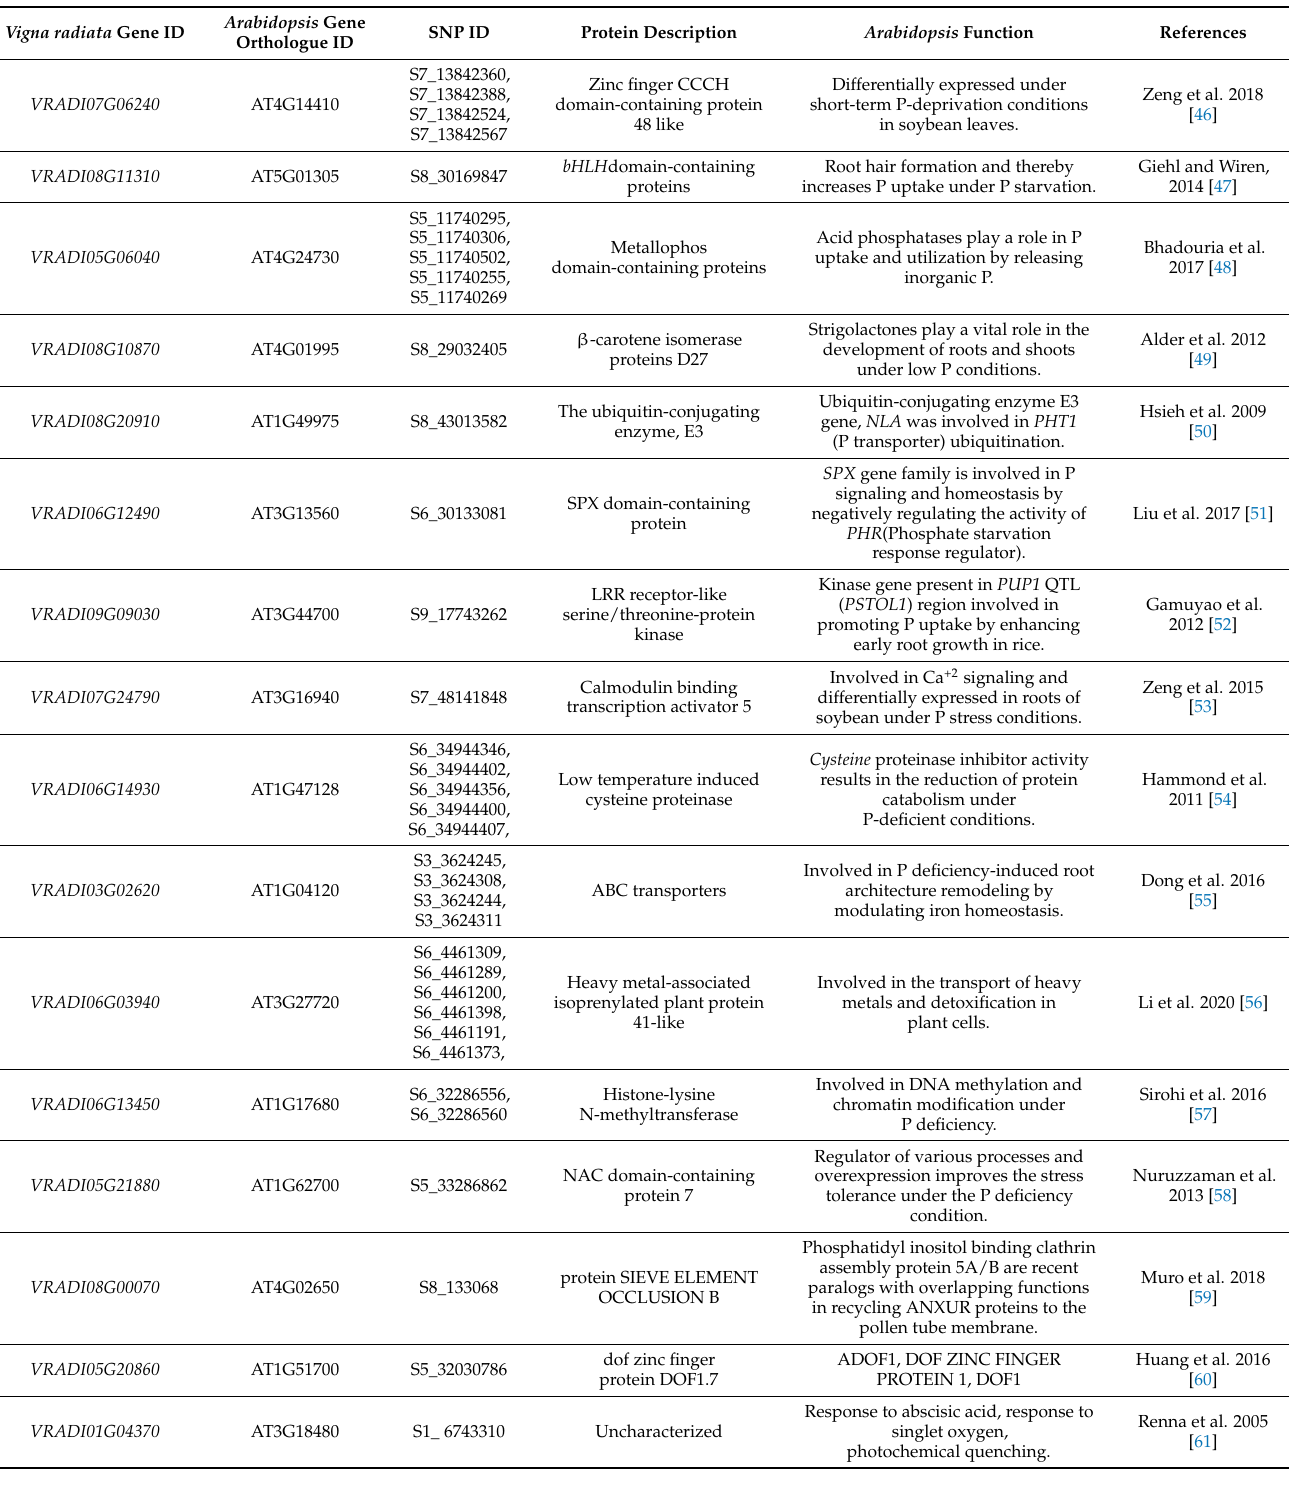
Table 3. Protein description of the identified genes related to P deficiency